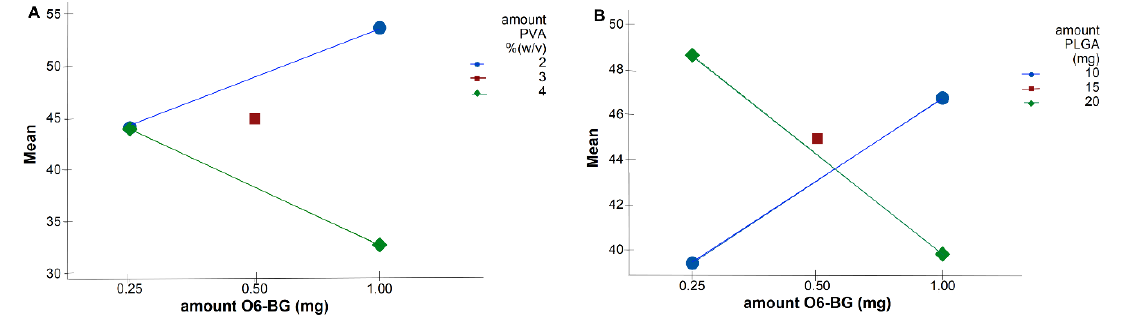
Figure 5. Interaction plots for EE of TMZ data means showing significant two-way interaction terms for the dependent variables. Solid blue lines display factors at a low level, whereas green dashed lines are the high level of the factors. ( A ) interaction term X 2 X 3 : amount of O6BG / amount of surfactant, ( B ) X 2 X 5 : amount of O6BG / amount of PLGA.